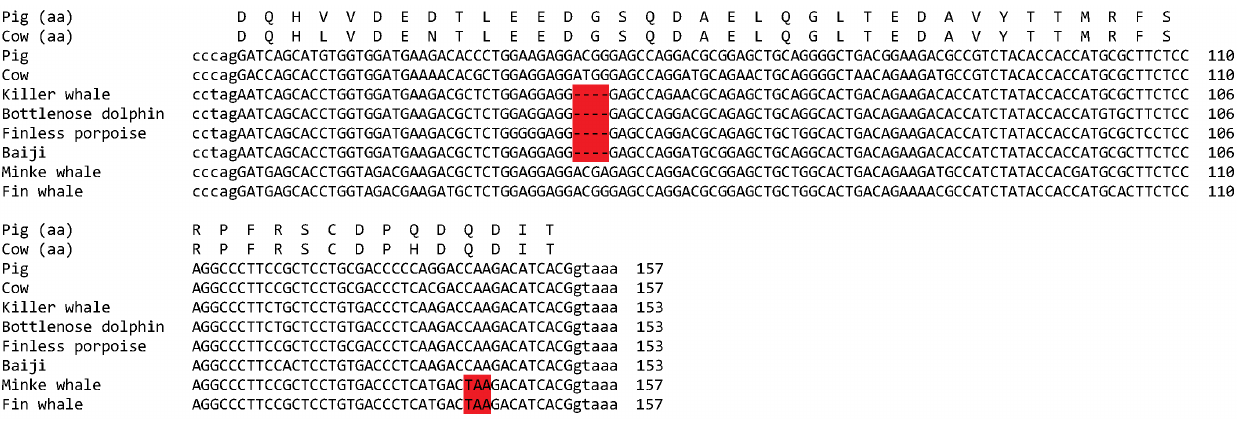
Figure 4. Disruptive mutations of the MOXD2 gene in whales. Exon 2 sequences of the pig ( Sus scrofa ), the cow ( Bos Taurus ), the killer whale ( Orcinus orca ), the bottlenose dolphin ( Tursiops truncatus ), the finless porpoise ( Neophocaena phocaenoides ), the baiji ( Lipotes vexillifer ), the minke whale ( Balaenoptera acutorostrata ), and the fin whale ( Balaenoptera physalus ) MOXD2 genes are shown. Disruptive mutations, a 4-nt deletion in toothed whales, and an inframe nonsense codon in baleen whales, are highlighted in red. Exon and intron sequences are in uppercase and lowercase letters, respectively. Additional mutations in other exons are presented in Figure S3.